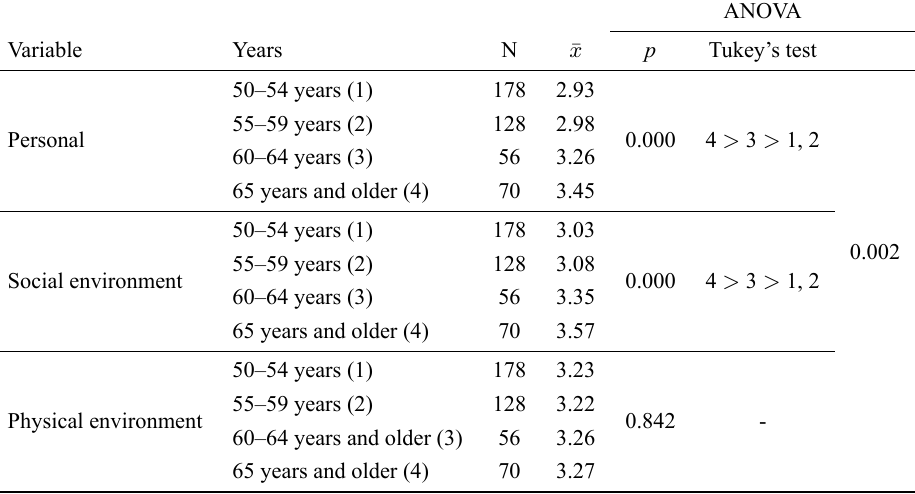
Table 3. ANOVA test results for subdimensions of barriers to physical activity, by age.